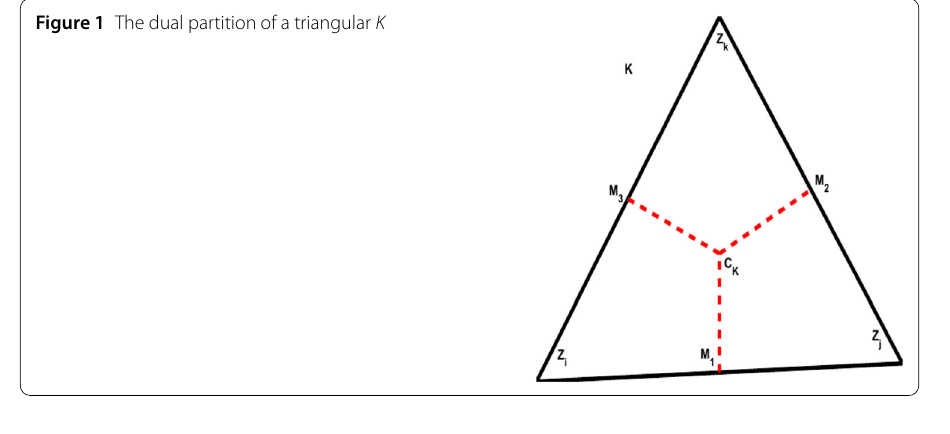
Figure 2 The control volume V i sharing the same vertex z